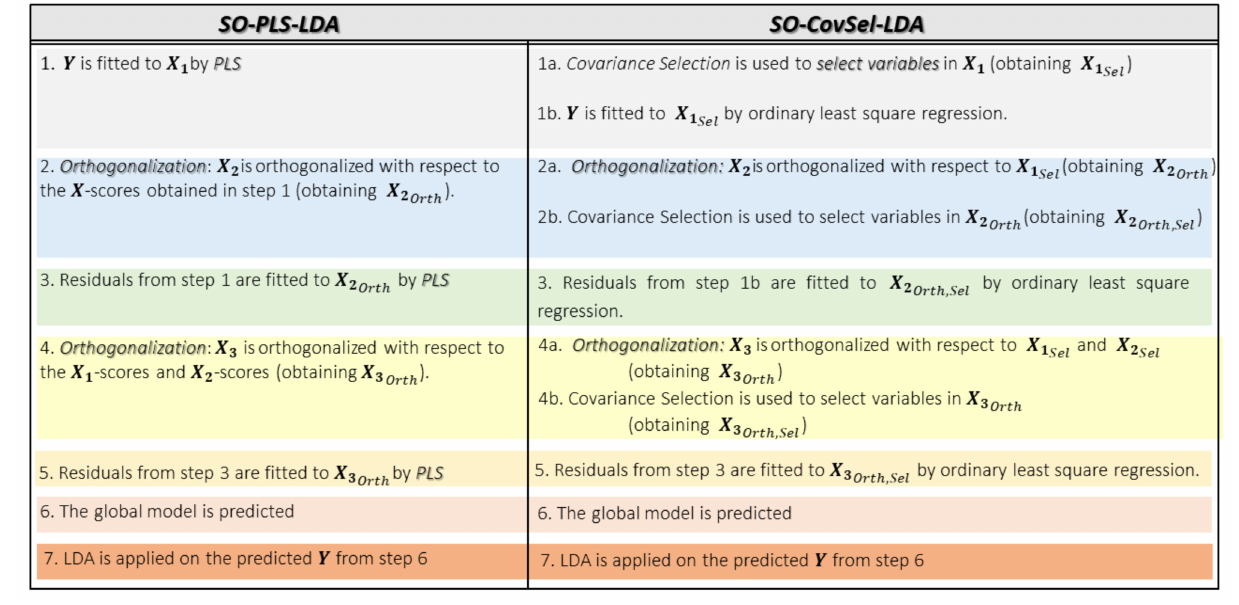
Figure 2. Scheme of the algorithm for SO-PLS ( left ) and SO-CovSel ( right ).